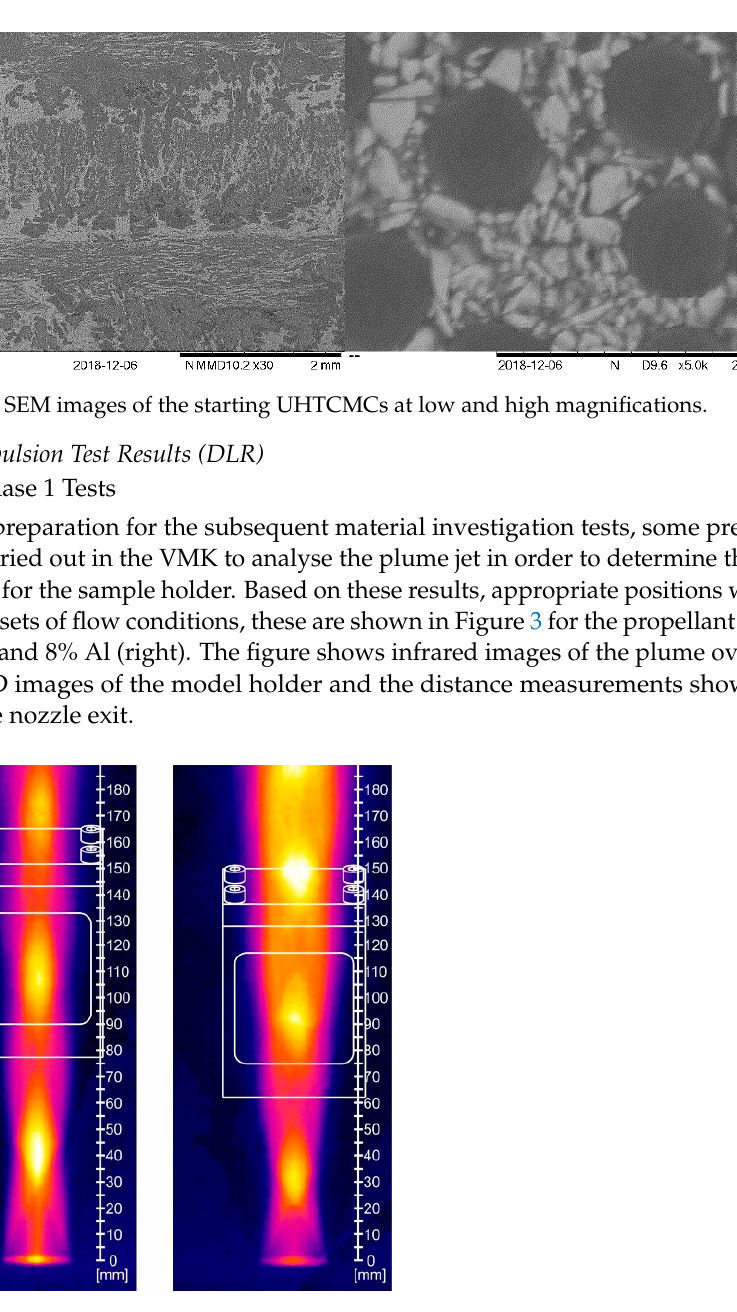
Figure 3. Overlap of IR-images with the locations of the sample holder for 2% Al ( left ) and 8% Al ( right ) propellants.